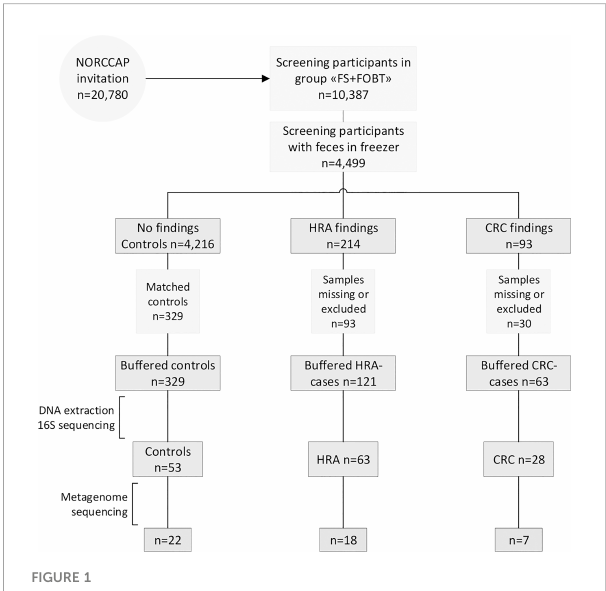
FIGURE 1 Recruitment fl owchart. Half of the NORCCAP participants were invited to deliver a stool sample in addition to participating in sigmoidoscopy screening. Half of these fecal samples were stored below − 20°C. A subset of samples diagnosed with CRC and HRA and healthy controls were included in the study and homogenized in preservation buffers. Those with suf fi cient DNA extracted were included in 16S rRNA ( n = 144) and metagenome sequencing ( n = 47). FS, fl exible sigmoidoscopy; FOBT, fecal occult blood